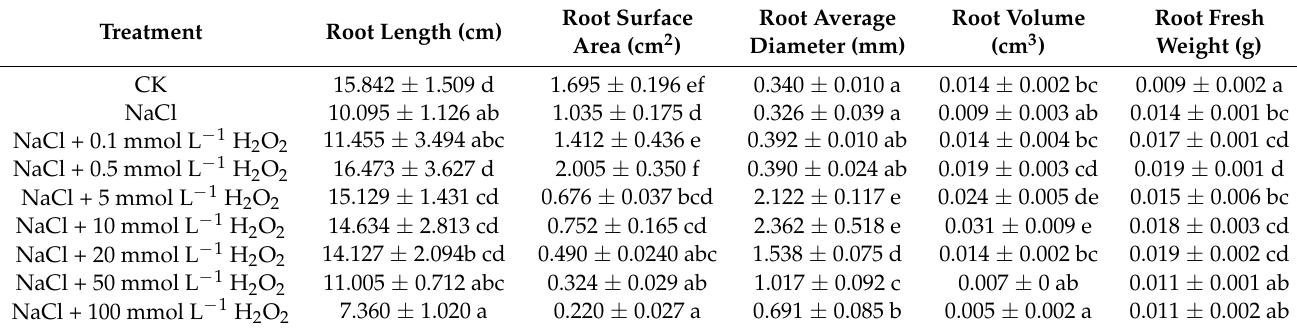
Table 2. Effects of H 2 O 2 on root growth of F. tataricum seedlings under NaCl stress. Treatment